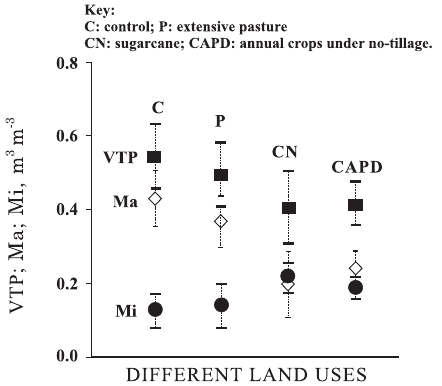
Figure 5. Mean values and confidence interval (95 %) for total soil porosity (TSP), macroporosity (Ma) and microporosity (Mi), calculated for the 0– 20 cm soil layer in areas of different land